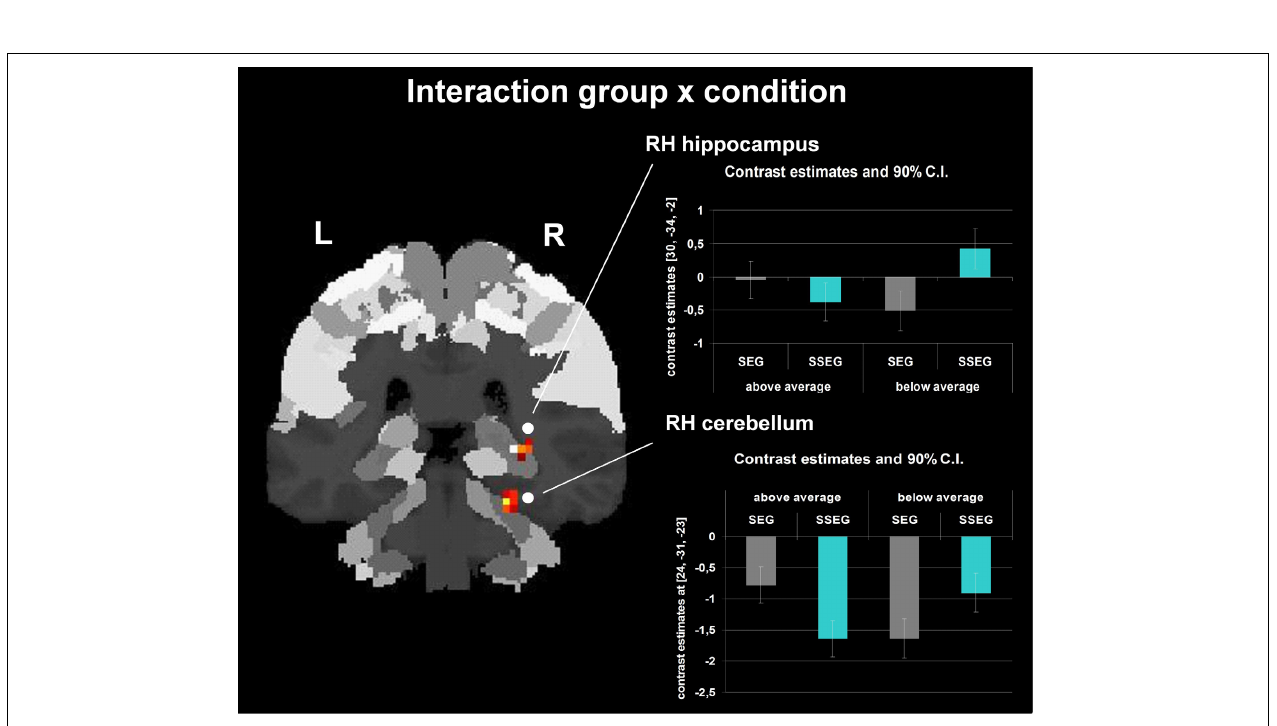
FIGURE 7 | Interaction between group and condition (uncorrected p < 0 . 001, k = 10 voxels). The bar charts next to the activation figure depict the corresponding beta estimates for the respective brain region.